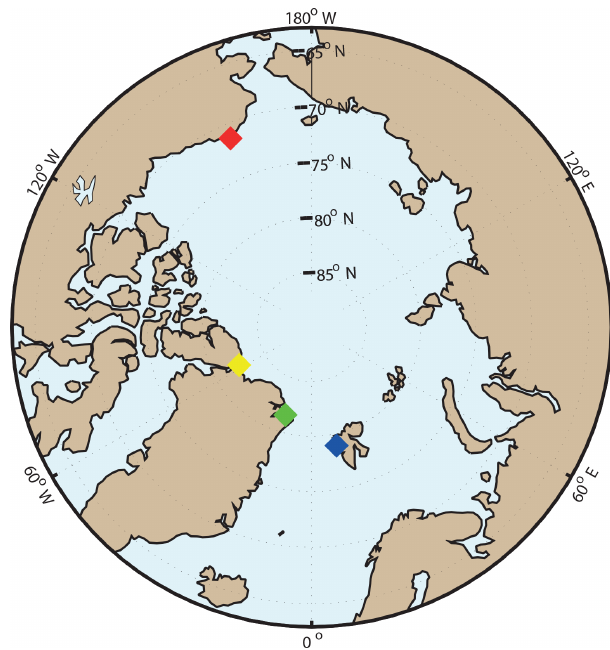
Figure 1. The location of the four stations from which filter sam- ples were included herein: Utqia˙gvik (red diamond), Alert (yellow diamond), VRS (green diamond), and Ny-Ålesund (blue